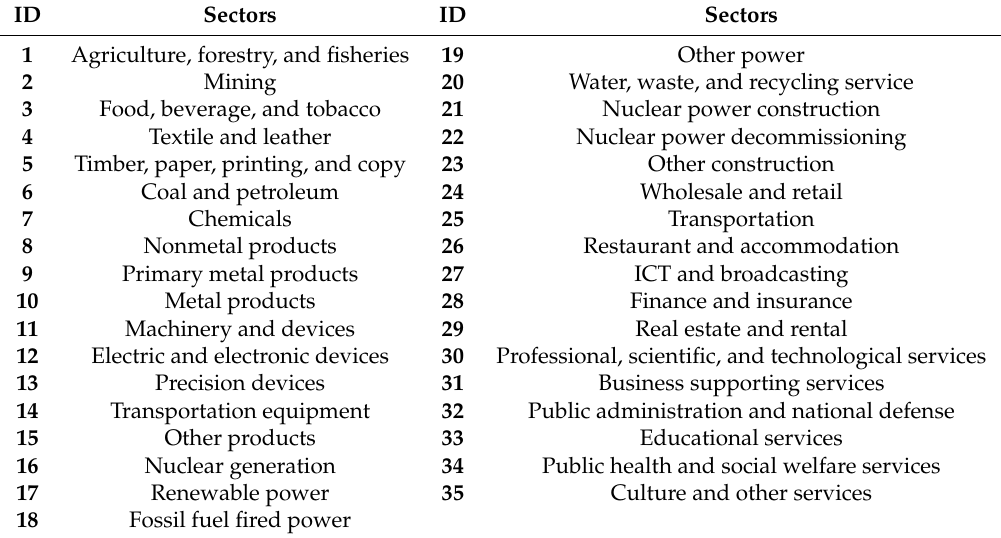
Table 2. Sector classification of input-output